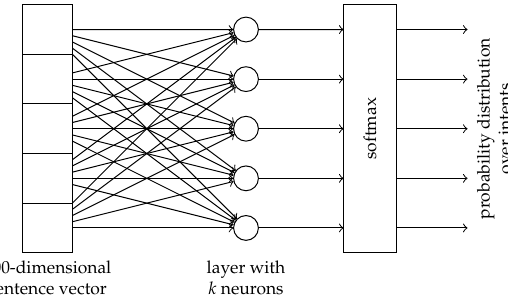
Figure 1. The architecture of the feedforward neural network, where k is the number of possible intents.